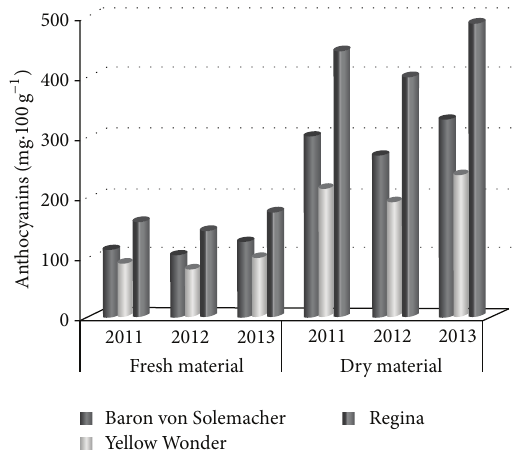
Figure 4: Content of anthocyanins (mg ⋅ 100g −1 ) in raw